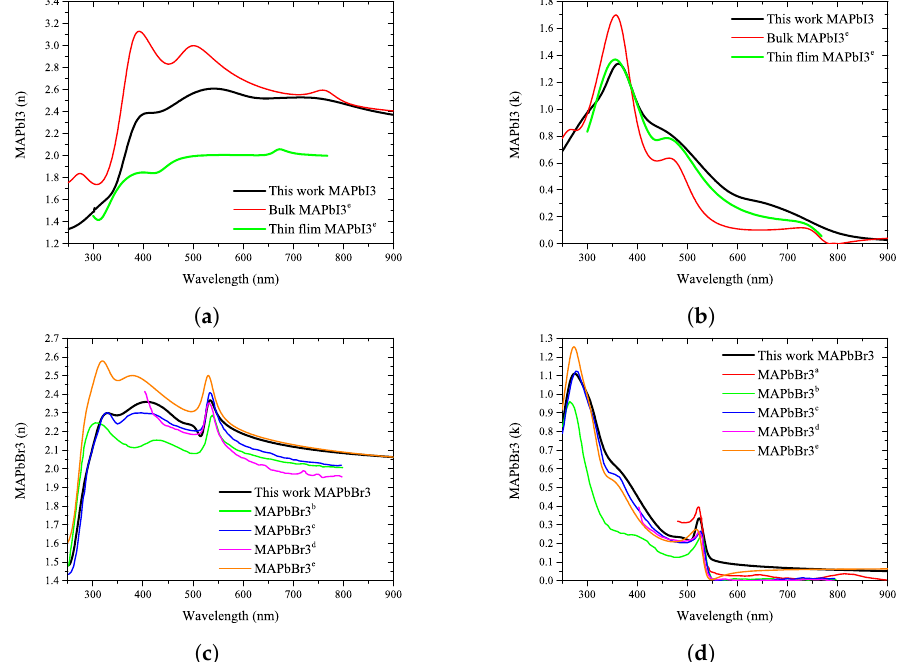
Figure 7. The optical property measurement results of the ellipsometry analysis of quaternary per- ovskite materials in this study were compared with the reference data from previously reported papers a − e [37,46–49]. ( a ) refractive index of MAPbI 3 , ( b ) extinction coefficient of MAPbI 3 , ( c ) refrac- tive index of MAPbBr 3 , ( d ) extinction coefficient of MAPbBr 3